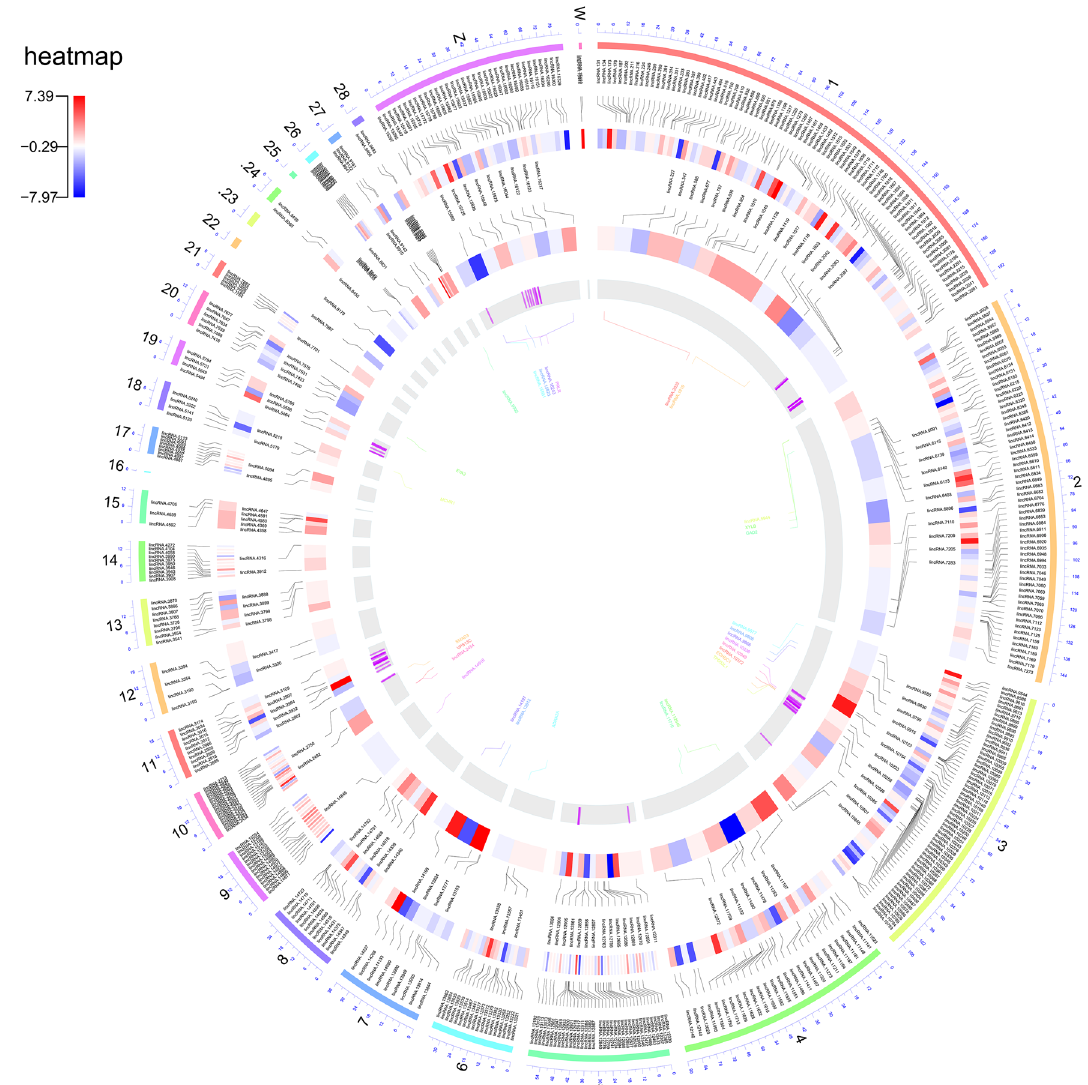
Figure 3. Circos plot represents the genome-wide distribution density of all the identified novel lncRNAs (in clockwise order). From outside to inside the plot shows the chromosomes, and the next ring the position of the novel lincRNAs, the log2 fold change (Esfahani against Ross) of the novel lincRNAs, position of the novel ilncRNAs, the log2 fold change (Esfahani against Ross) of the novel ilncRNAs, the location of Residual feed intake QTLs from animal QTL database and the names of promising lncRNAs and mRNAs pairs associate with Residual feed intake. Red heatmap colors represent the higher expression of the gene in Esfahan than Ross